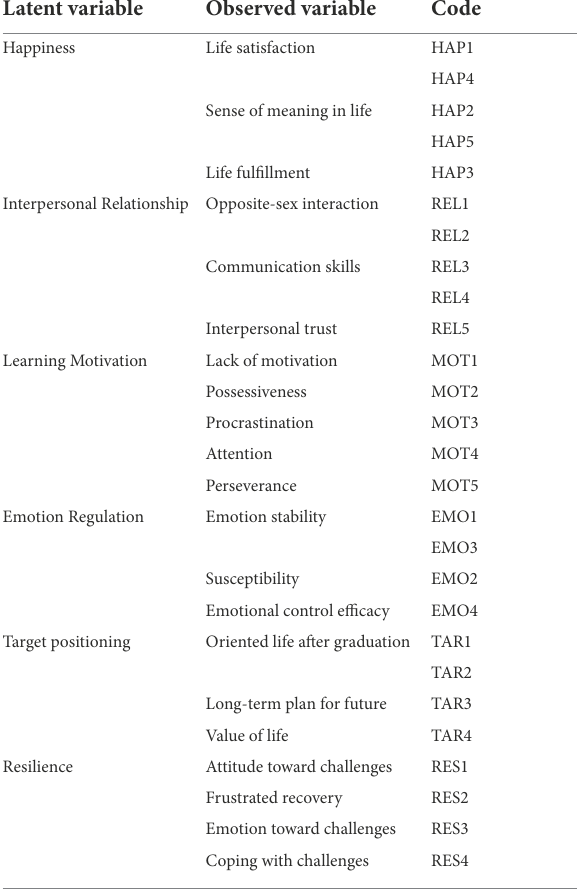
TABLE 1 The relationship between latent variables and observed